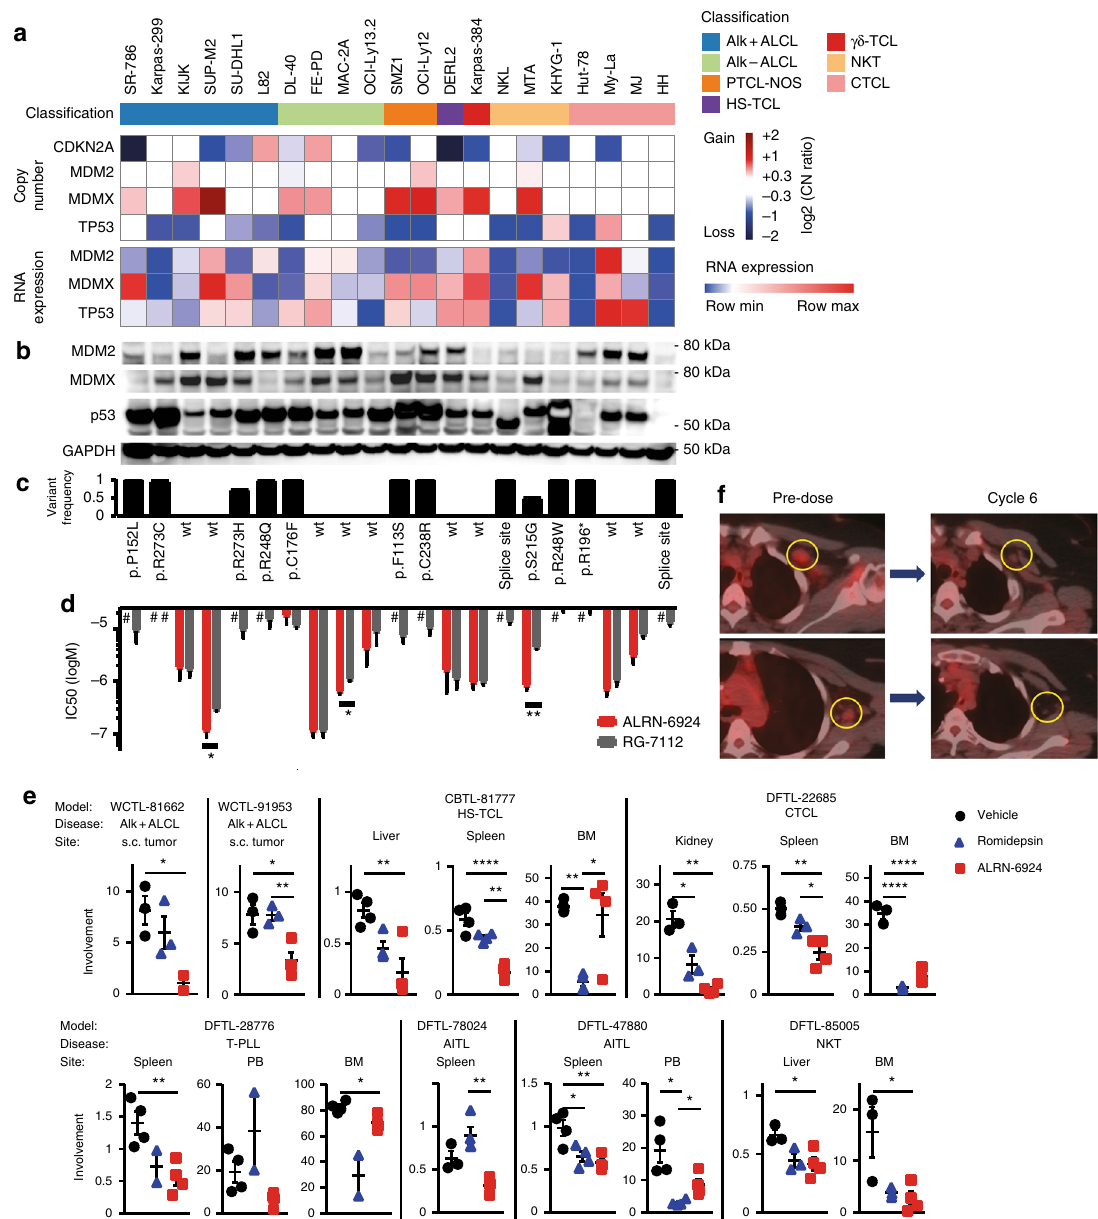
Fig. 3 Targeting MDMX and MDM2 with ALRN-6924 a Copy number variants and RNA expression levels of MDM2 , MDMX , and TP53 across 21 T- and NK-cell lymphoma cell lines. b Protein levels of MDM2, MDMX and p53 by immunoblotting, corresponding to a . c TP53 mutation status, corresponding to a . d IC50 values of ALRN-6924 and RG-7112, corresponding to a . Bar graphs indicate mean values of at least two independent experiments performed in quadruplicates with error bars indicating standard error of the mean. Statistics: Unpaired two-sided t -test, * p < 0.05, ** p < 0.01. e Tumor burden at all involved sites for each mouse. Tumor involvement is represented as % tumor weight per body weight for subcutaneous (s.c.) tumors, % spleen per body weight and % in fi ltration of hCD45/hCD2 + cells for bone marrow (BM) and peripheral blood (PB). Liver involvement is presented in grams, assessed by liver weight x % in fi ltration of hCD45/hCD2 + cells. Comparisons are by two-sided t -test with Welch correction. Error bars indicate standard error of the mean. f PET-CT scan showing axillary lymph node involvement with AITL at two sites (circled) prior to treatment with ALRN-6924 and complete remission after cycle